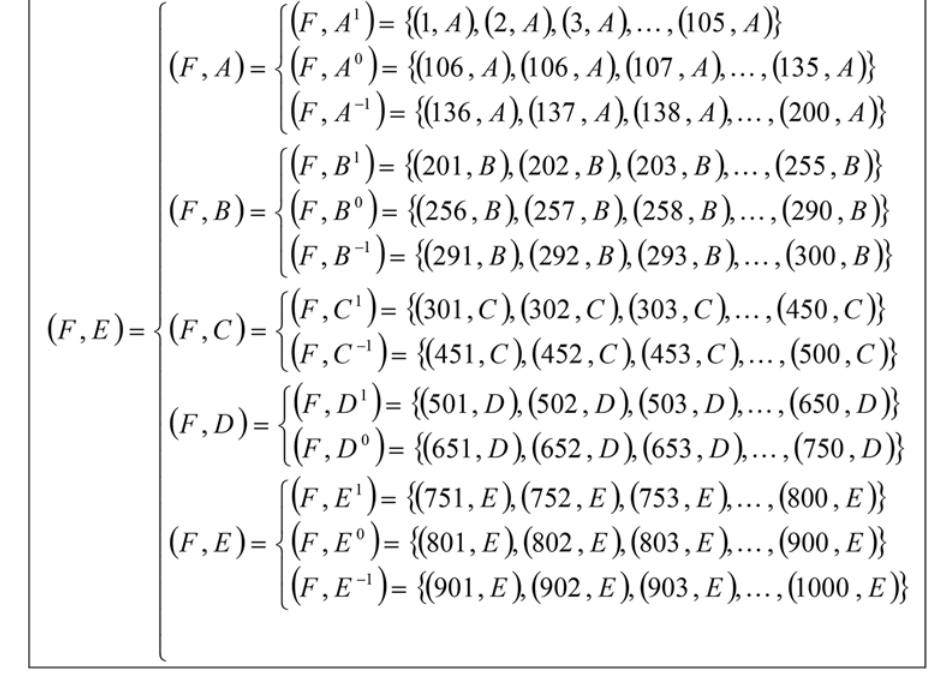
Fig 3. Multi-soft sets representations from Tables 3 – 7.